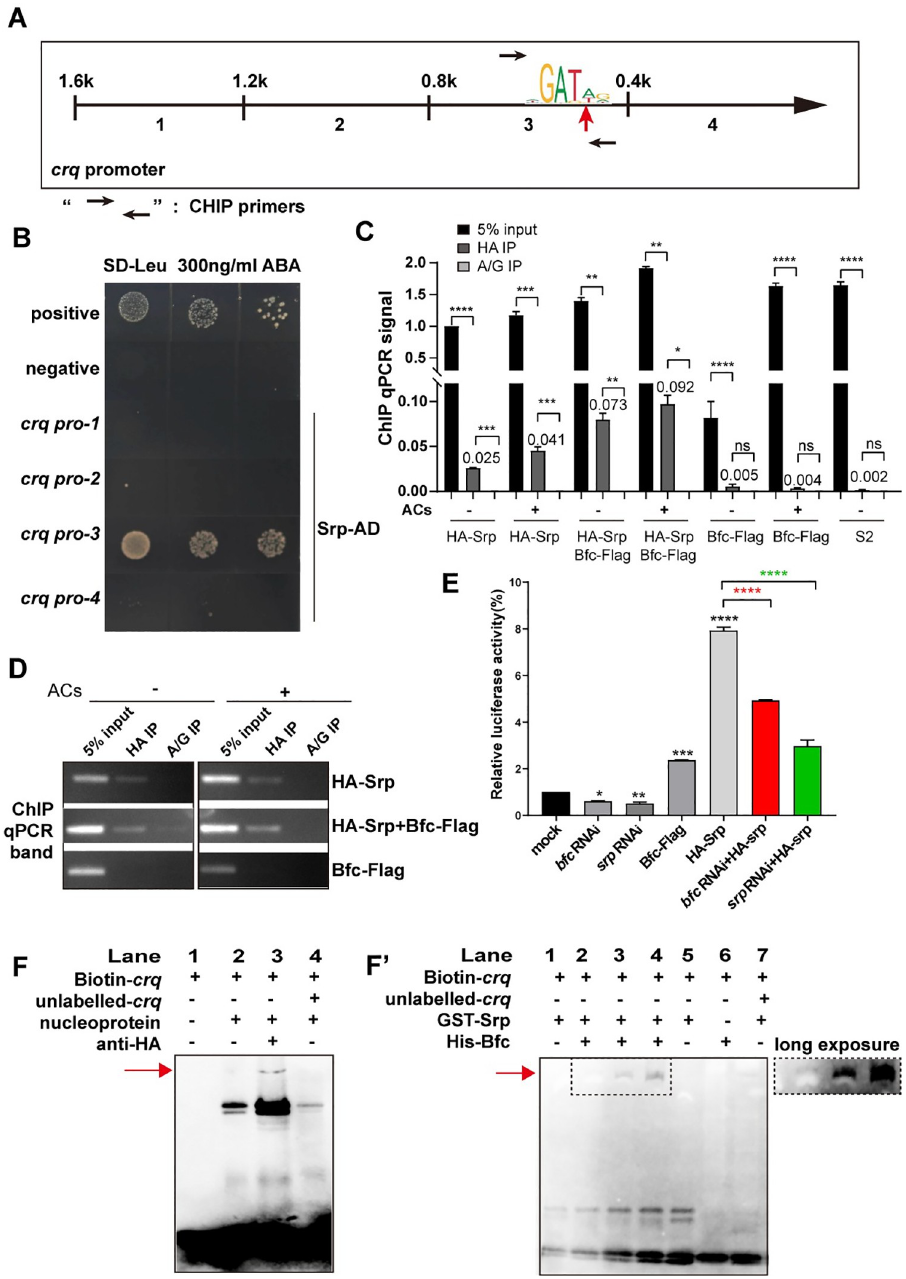
Fig 6. Srp binds to the GATA motif in the crq promoter. A. Schematic representation of the crq promoter region; the red arrowhead indicates the predicted Srp binding site, and the black arrows indicate the primers used for the ChIP-qPCR. B. Yeast One-hybrid assays with yeast strains containing different prey (Srp-AD)—bait ( crq promoter plasmids) combinations. C. The crosslinked chromatin of S2 cells expressing HA-Srp, HA-Srp+Bfc-Flag, or Bfc-Flag, incubated or not with ACs was immunoprecipitated with either anti-HA beads or control protein A/G. The ChIP- qPCR efficiency (compared to 5% input) is shown. Protein A/G was used as the negative control. D. The gel image shows the input DNA or immunoprecipitated DNA bands of the ChIP-qPCR in ( C ). E. Effect of bfc and srp RNAi treatments on the luciferase activity of crq promoter reporter constructs. All the samples were tested after the addition of ACs. The mean activity with the standard deviation of three independent transfections is represented. Statistical significance was assessed using the one-way ANOVA. F. Nuclear proteins extracted from HA-Srp transfected S2 cells binding to biotin-labeled crq promoter probe and EMSA supershift with and without anti-HA antibodies. The red arrows point to supershifted bands. F’. Purified GST-Srp protein binding to biotin-labeled crq probe and supershift with purified